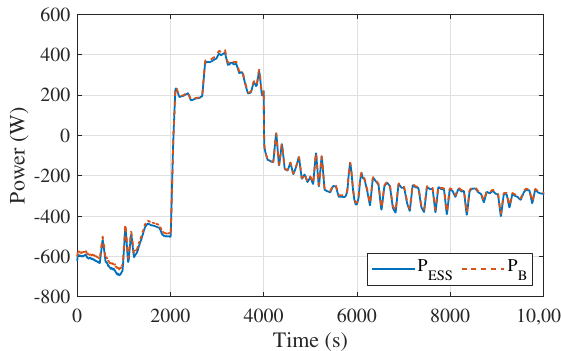
Figure 3. Power profile in the battery-alone ESS system.